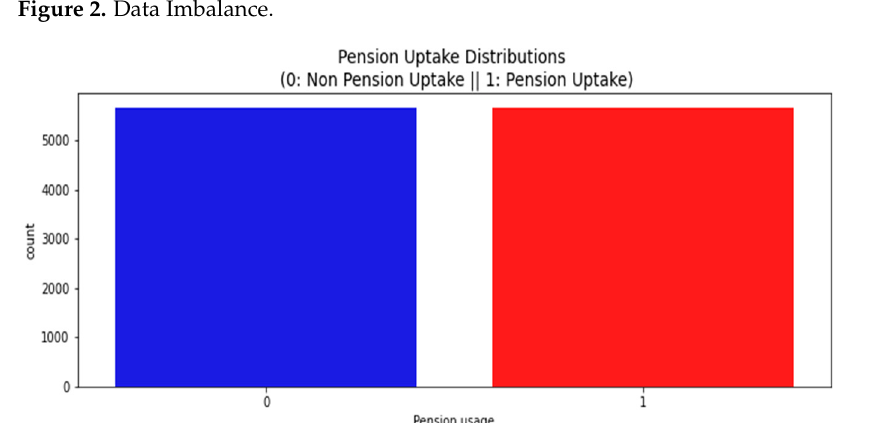
Figure 2. Data Imbalance.